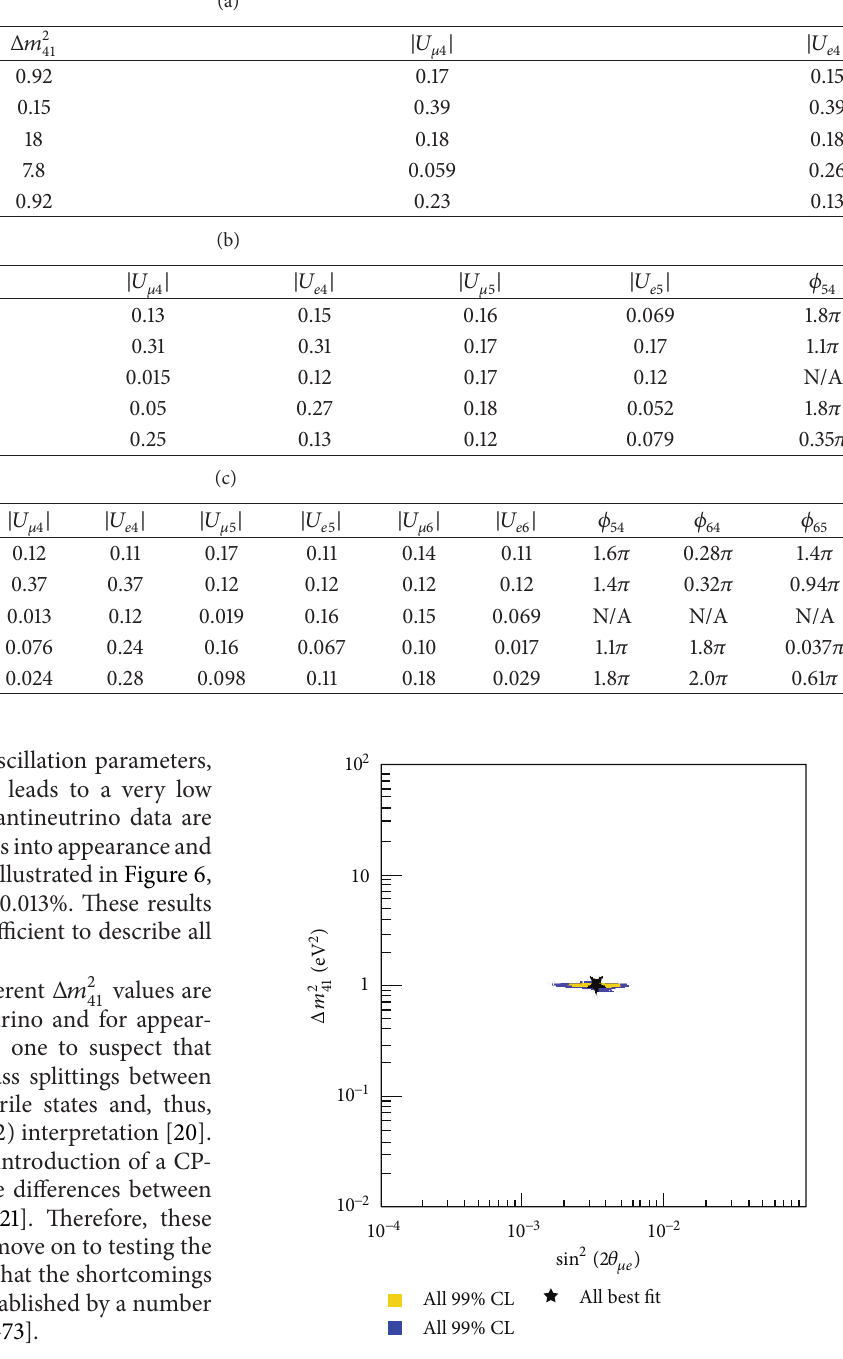
Figure 4: The Δ𝑚 2 41 versus sin 2 2𝜃 𝜇𝑒 allowed space from fits to all data—neutrino and antineutrino—in a ( 3 + 1 ) model. (see Table 2) and reducing the 𝜒 2 of the global fit by